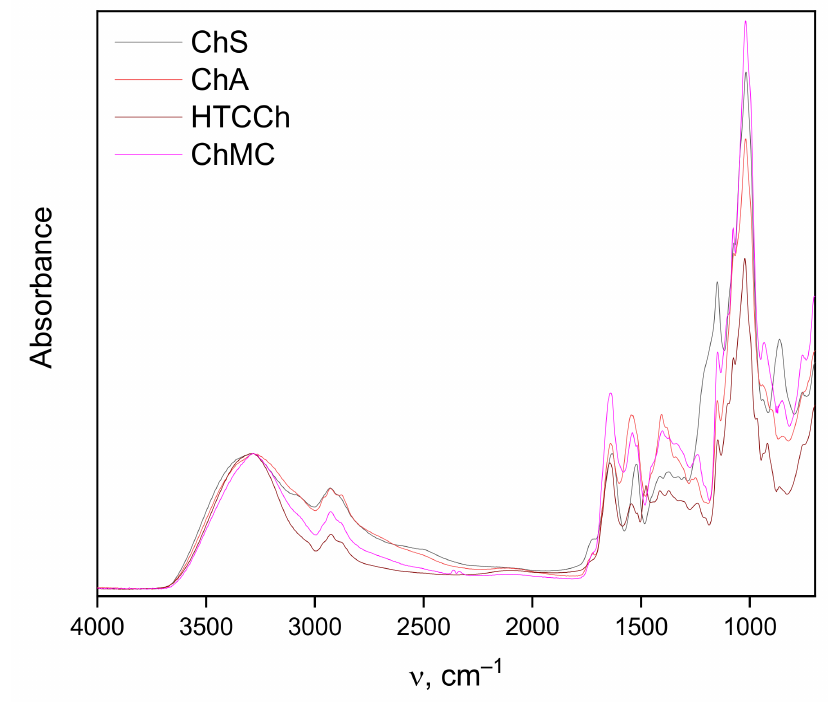
Figure 4. FTIR spectra of dry preparations of bromelain on ChS, ChA, HTCCh, and ChMC matrices. The intensities of the spectra in the 3000–3600 cm − 1 region of the stretching vibrations of OH groups are normalized to the maximum of the 3300 cm − 1 band and allow a rough estimate of the intensity distribution of hydrogen bonds: OH groups with stronger hydro- gen bonds absorb at lower frequencies. The number of OH groups absorbing below the center frequency of 3300 cm − 1 is the smallest in the bromelain/HTCCh system,